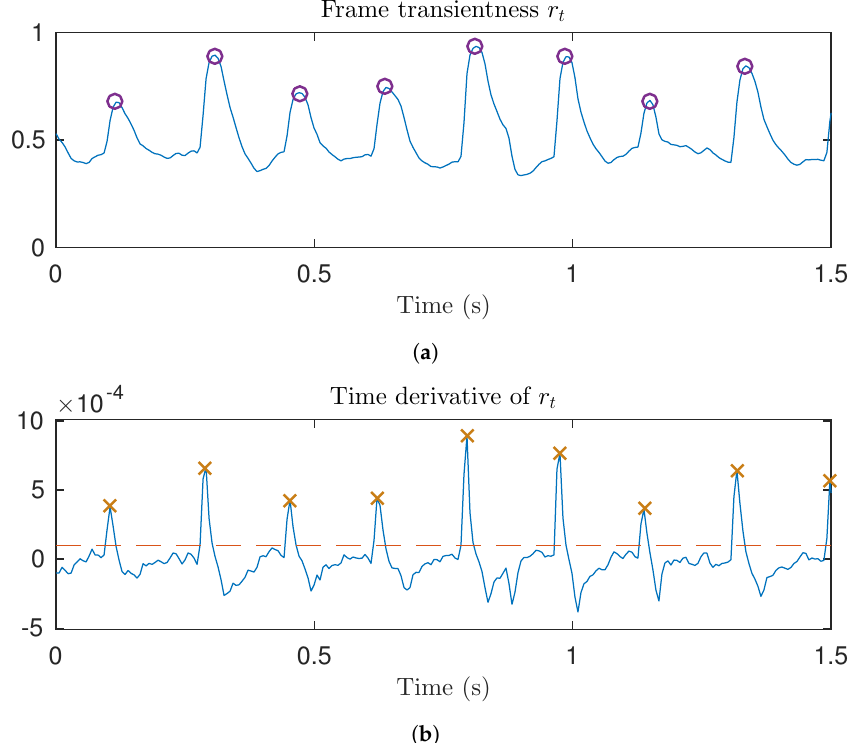
Figure 6. Illustration of the proposed transient detection. ( a ) Frame transientness. Locations of the detected transients are marked with purple circles; ( b ) Time derivative of the frame transientness. Detected transient onsets are marked with orange crosses. The red dashed line shows the transient detection